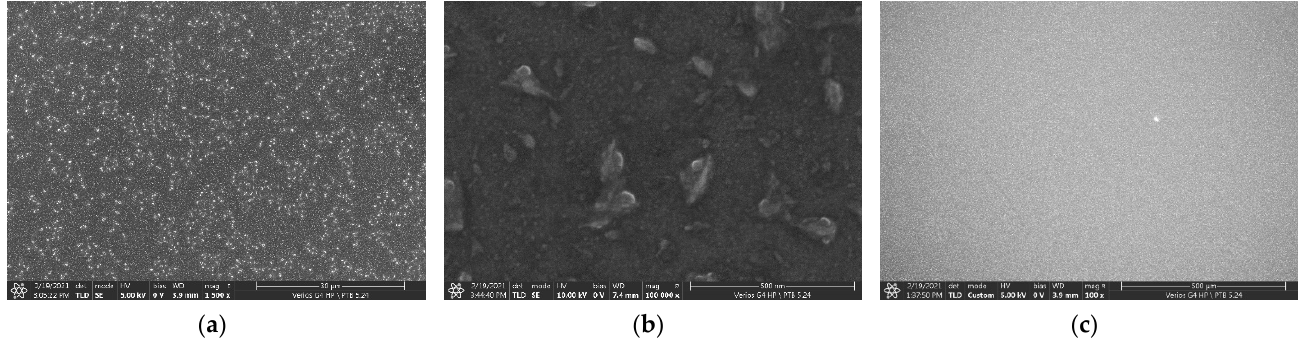
Figure 4. Secondary-electron SEM Images (through-lens detector) of thermal-PVD 226 RaCl 2 on a bare 1” prime Si-wafer at different magnifications: ( a ) 1500×, ( b ) 100,000×, ( c ) 100×. Length of bar: ( a ) 30 µm ( b ) 500 nm, ( c ) 500 µm.